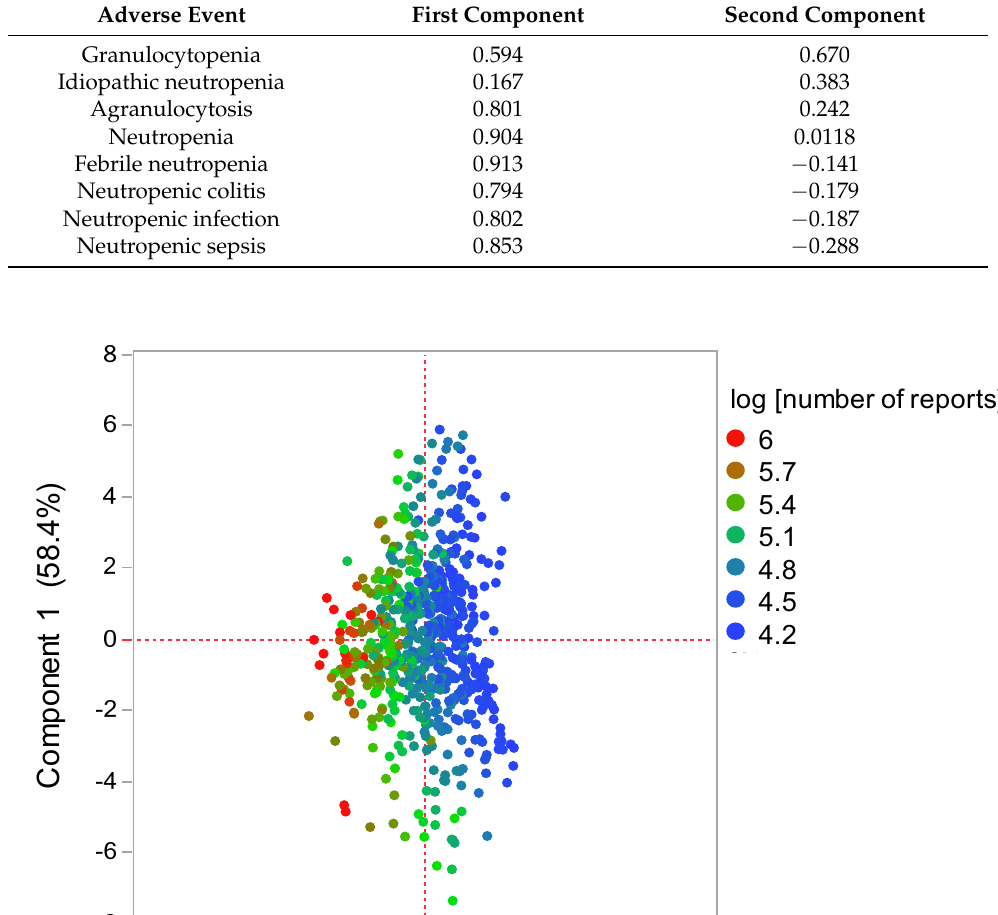
Table 3. Principal component load related to CIN.